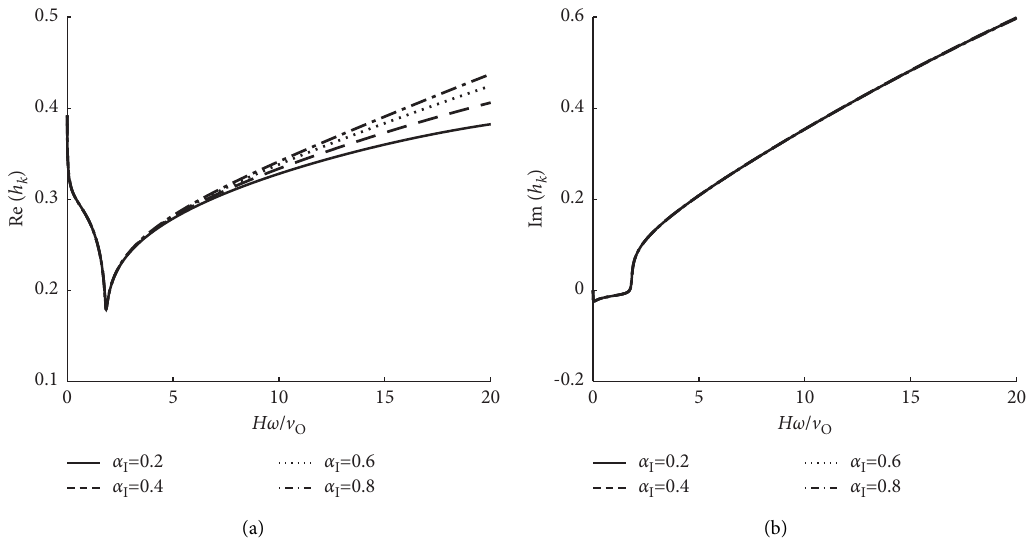
Figure 5: The impedance factor curves of the pile core soil under different fractional derivative orders. (a) Horizontal stiffness factor of the soil layer. (b) Horizontal damping factor of the soil